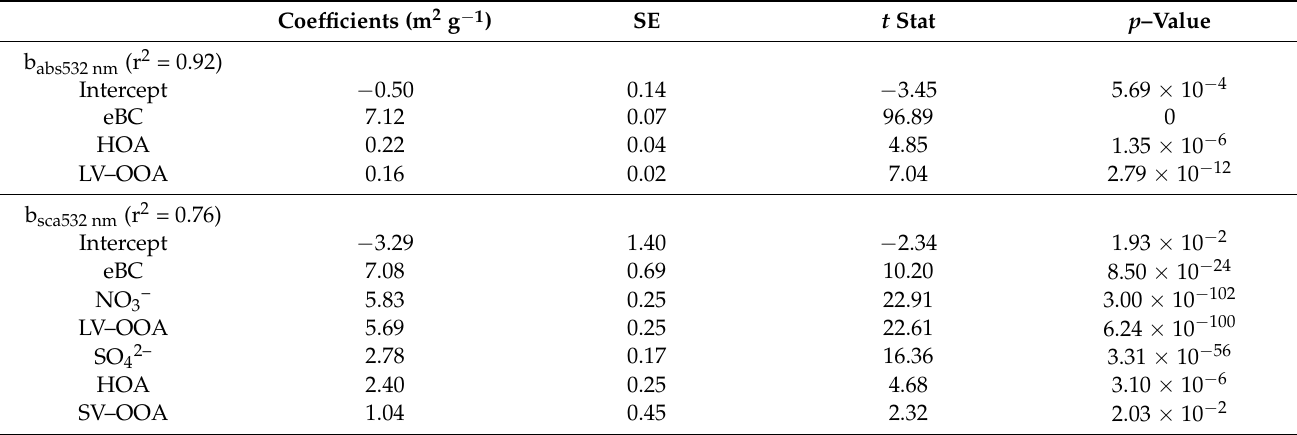
Table 2. Statistics of multiple linear regressions (MLR). r 2 stands for determination